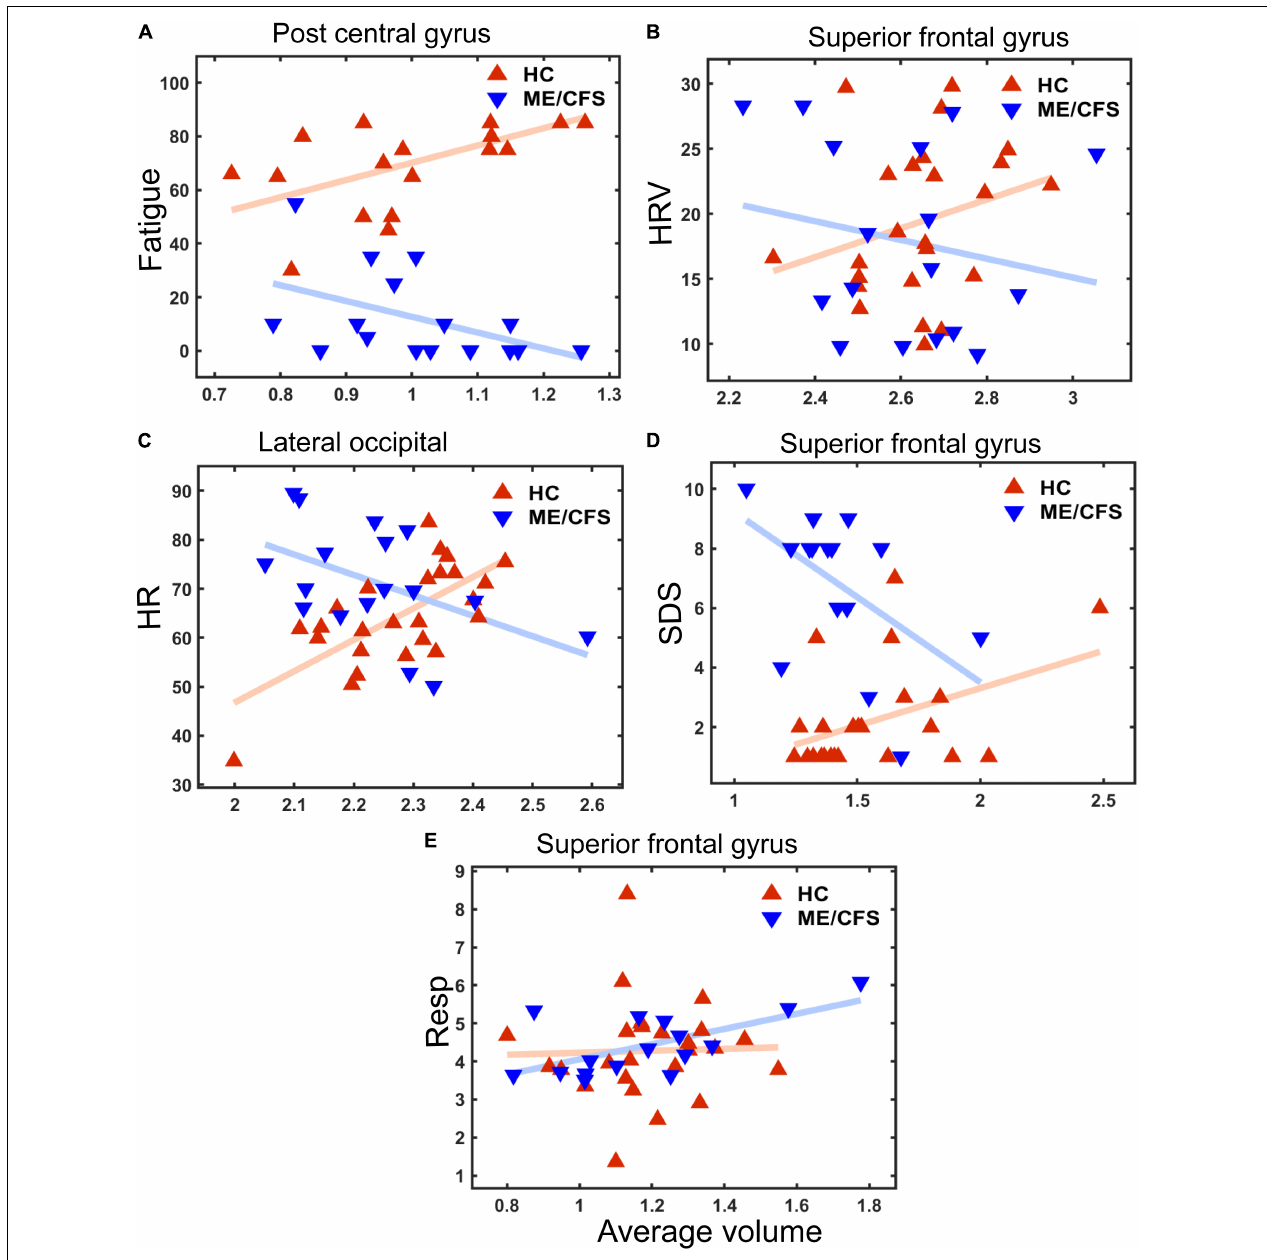
FIGURE 6 | Plots for cluster average volume vs. five clinical measures (see Y-axis label). The X axis is “Average Volume,” the spatial average of the local volumes in the cluster. (A) Fatigue score (cluster p ≤ 0.0001 in postcentral gyrus—see Figure 2 ). (B) Heart Rate Variability (HRV) (cluster P = 0.0028 in superior frontal gyrus– see Figure 2 ); (C) Heart rate (HR) (cluster p = 0.0002 in lateral occipital– see Figure 3 ); (D) Sleep disturbance score (SDS) ( p = 0.002 in superior frontal gyrus– see Figure 4 ); (E) Respiration Rate (Resp) (cluster p = 0.038 in superior frontal gyrus—see Figure 5 ). Lines are linear fits to individual values. Average volume (x-axis) was default volume obtained from the “mri_glmfit-sim” command from FreeSurfer that computes a spatial average inside a